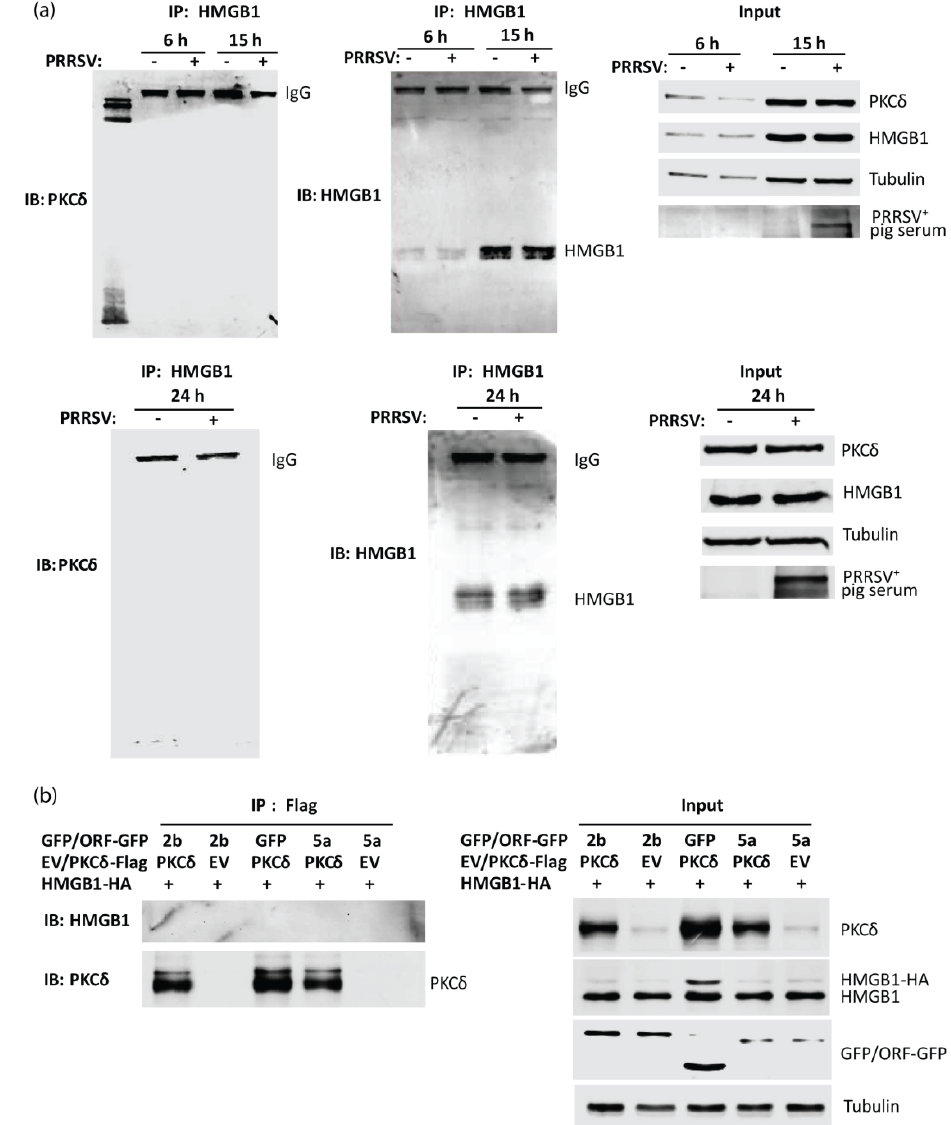
Figure 3. The interaction between PKCδ and HMGB1 is below the detection level. ( a ) HMGB1 IP fails to precipitate PKCδ in PRRSV-infected MARC-145 cells. The cells were infected with HuN4 at an MOI of 1 and were harvested for IP with HMGB1 antibody at 6, 15, and 24 hpi, followed by IB. The band of immunoglobulin G (IgG) from IP elusion is indicated. The input was included in IB. PRRSV + pig serum was used for detecting PRRSV infection. ( b ) PKCδ IP fails to precipitate HMGB1 in HEK293T cells. The cells were co-transfected with HMGB1-HA, PKCδ-Flag, and PRRSV ORF2b or ORF5a plasmids. At 30 h after transfection, the cells were harvested for IP with Flag antibody, followed by IB with antibodies against HMGB1 and PKCδ. The input was included in IB.